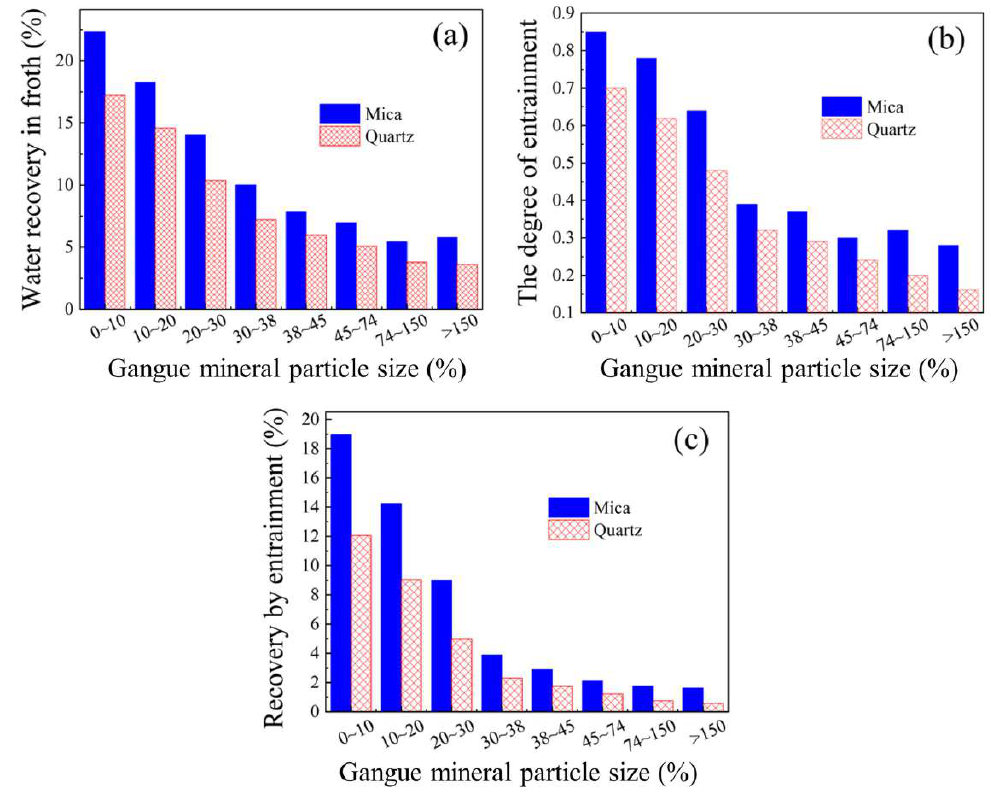
Figure 6. The effect of gangue particle size on its entrainment behavior: ( a ) the water recovery in froth; ( b ) the degree of entrainment; and ( c ) the recovery of gangue by